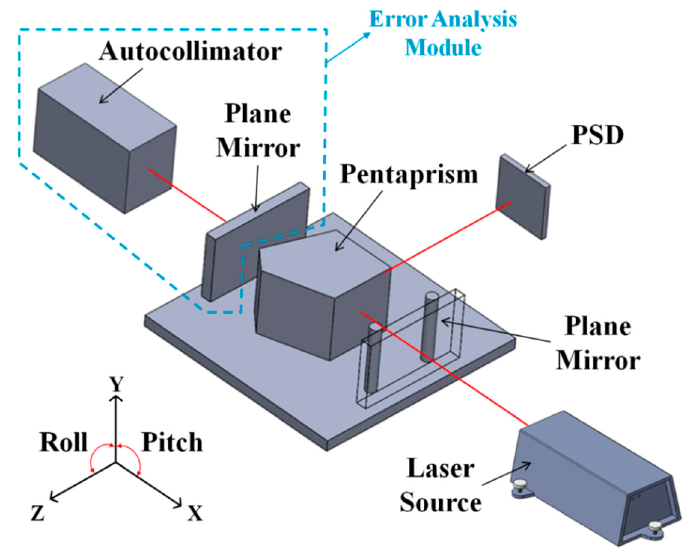
Figure 12. Schematic diagram of the pentaprism setup error detection. Table 3. Uncertainty analysis of the pentaprism setup.